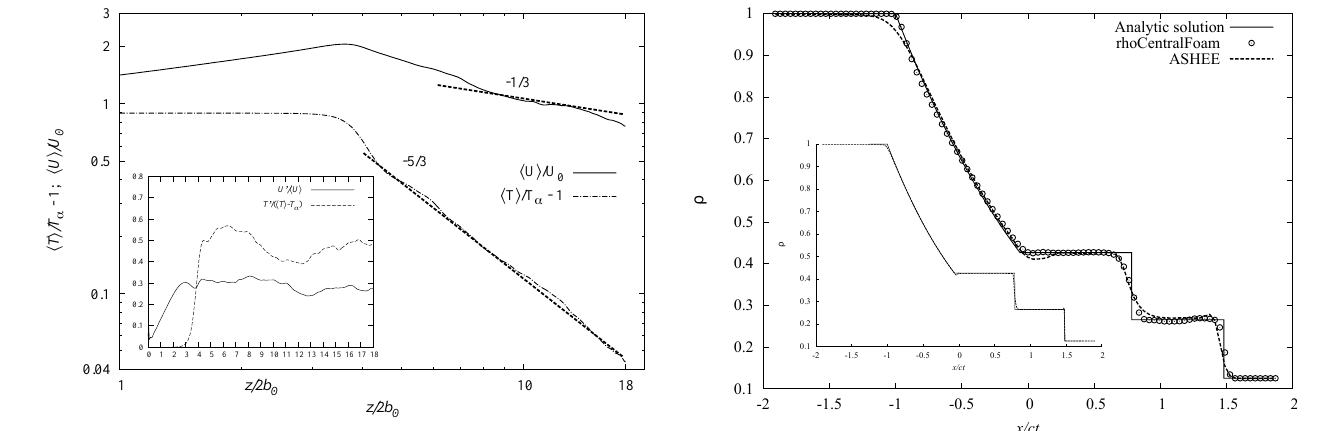
Figure 15. The Sod (1978) shock tube density after 0.007s (here c = 374 . 348ms − 1 ). Here we compare the analytic solution (solid) with two simulations performed with ASHEE model (dashed line) and the OpenFOAM ® rhoCentralFoam solver (circles). The resolution is 100cells, while in the inset the solution obtained with the ASHEE model with a resolution of 1000cells is reported